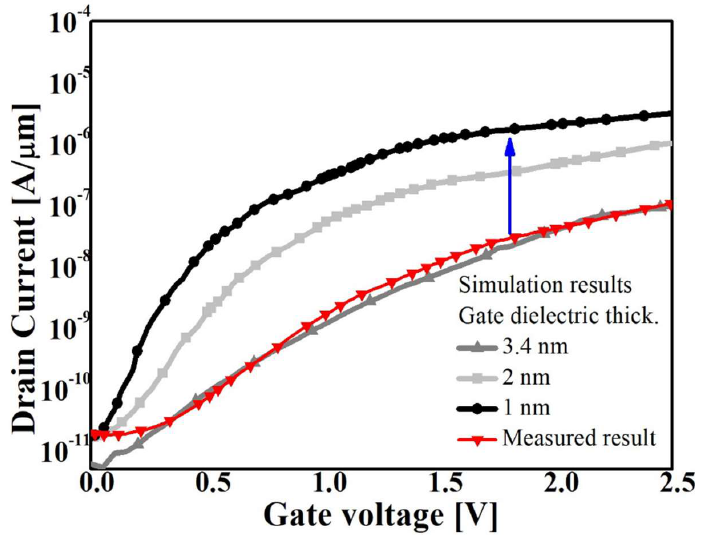
Figure 10. Transfer characteristics of the proposed TFETs with various CET.